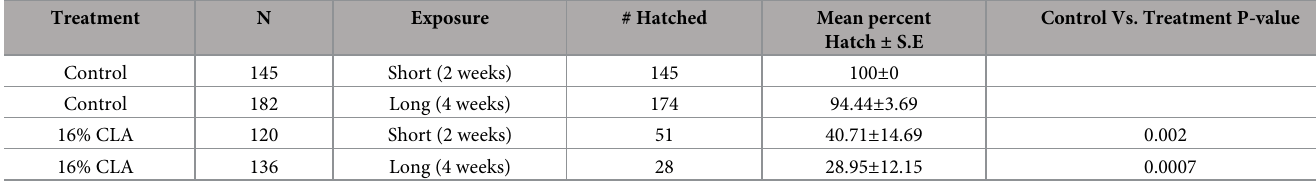
and 18:3n-3, and an increase in CLA isomers. The Δ 9-desaturase activity in eggs was decreased in the 16% CLA treated group compared to controls ( P = 0 . 027) . Adult choice assay Adult beetles did not display a preference between leaf material treated with the control aque- ous suspension comprised of water/tween-20 (0.125% v/v) and untreated leaf material Table 1. Adult L . decemlineata feeding assay and corresponding egg viability.